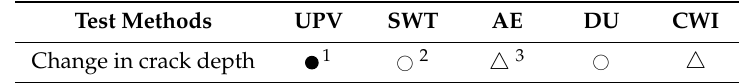
Table 1. Evaluation of change in crack size due to self-healing.